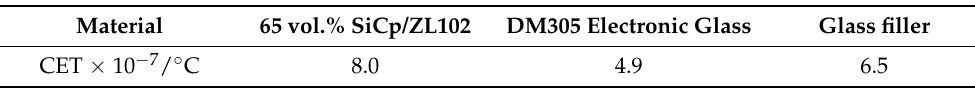
Table 3. Coe ffi cient of thermal expansion of 65 vol.% SiCp/ZL102 MMCs, DM305 electronic glass, and glass fi ller (0~300 °C).